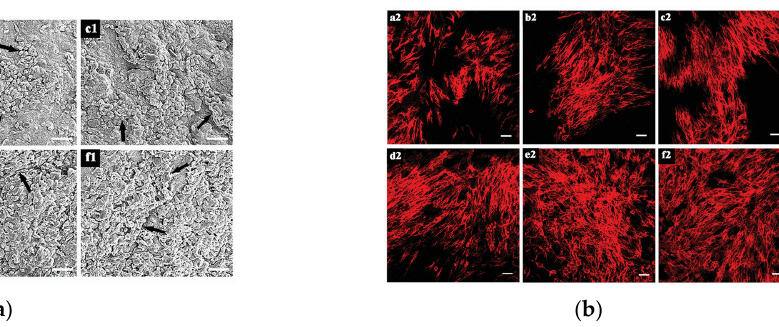
Figure 8. ( a ) SEM images of NIH3T3 cells after culturing on the rBC-based hydrogels for 3 days. The black arrow indicates NIH3T3 cells on different hydrogels. ( b ) LSCM images of NIH3T3 cells after culturing on rBC-based hydrogels for 7 days. In (a1–f1) and (a2–f2), each of the six images represents the six different groups, rBC hydrogel and rBC/MXene hydrogels with 0.1, 0.2, 0.5, 1 and 2 wt% of MXene, respectively. Scale bars are all 25 μ m. Data reproduced from ref. [104].